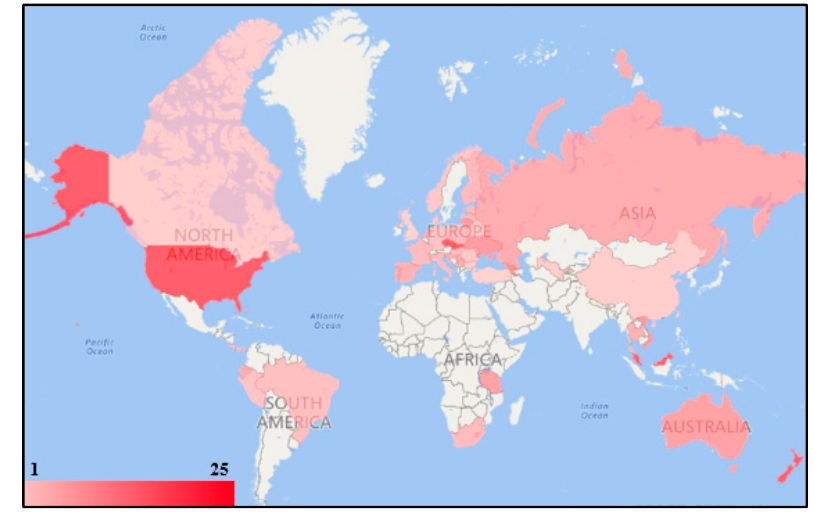
Figure 2. Geographic distribution of the nations regulating the 25 selected pesticides in residential surface soil.